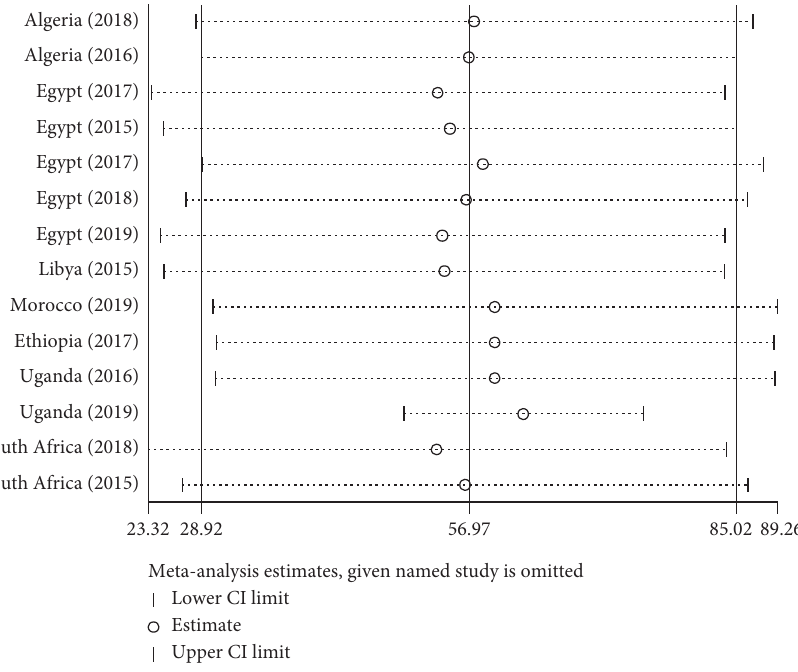
Figure 11: Sensitivity analysis for the pooled prevalence of CPAB in Africa from 2007 to 2017